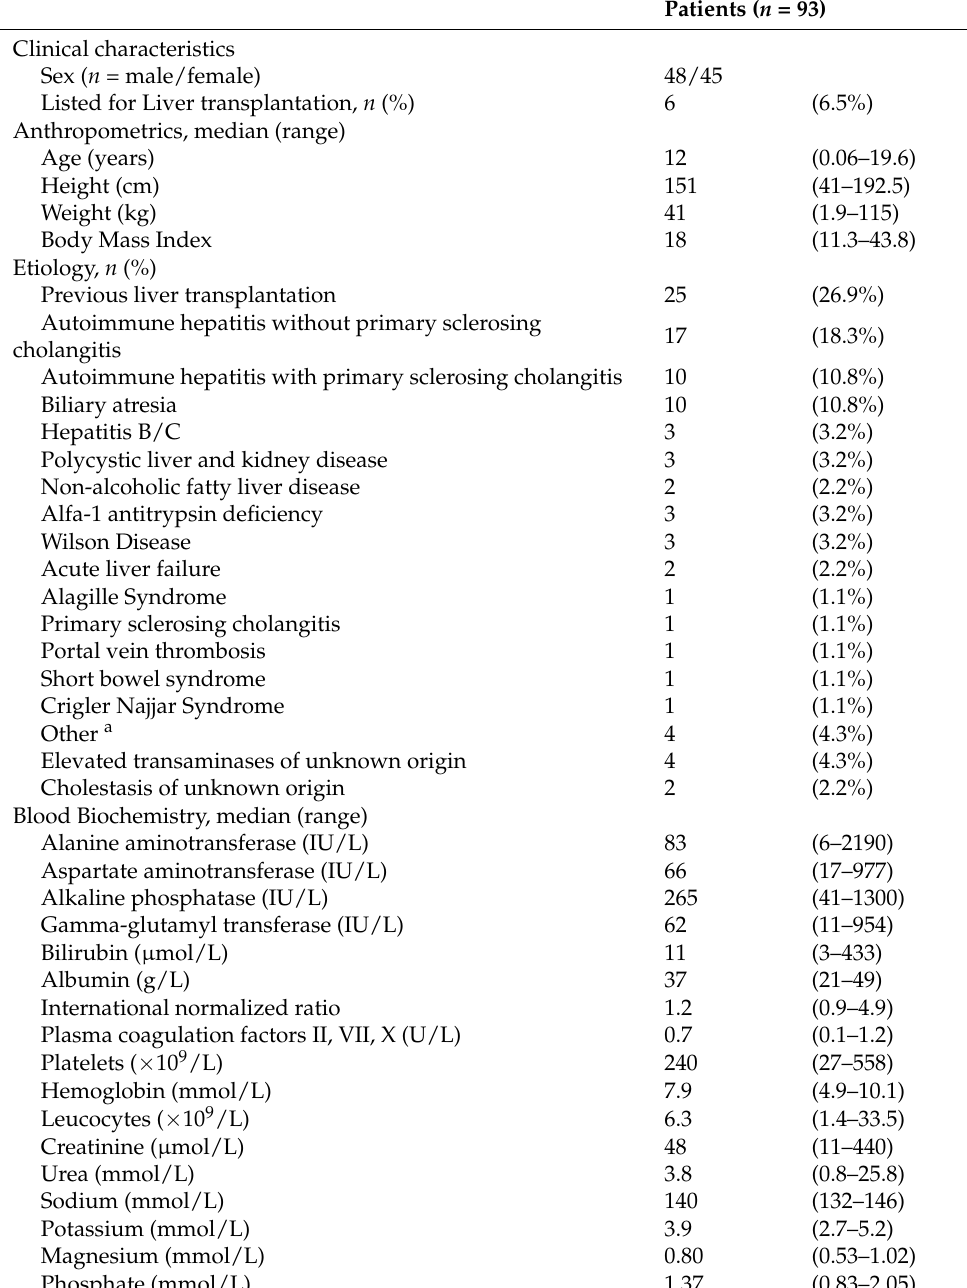
Table 1. Characteristics of included